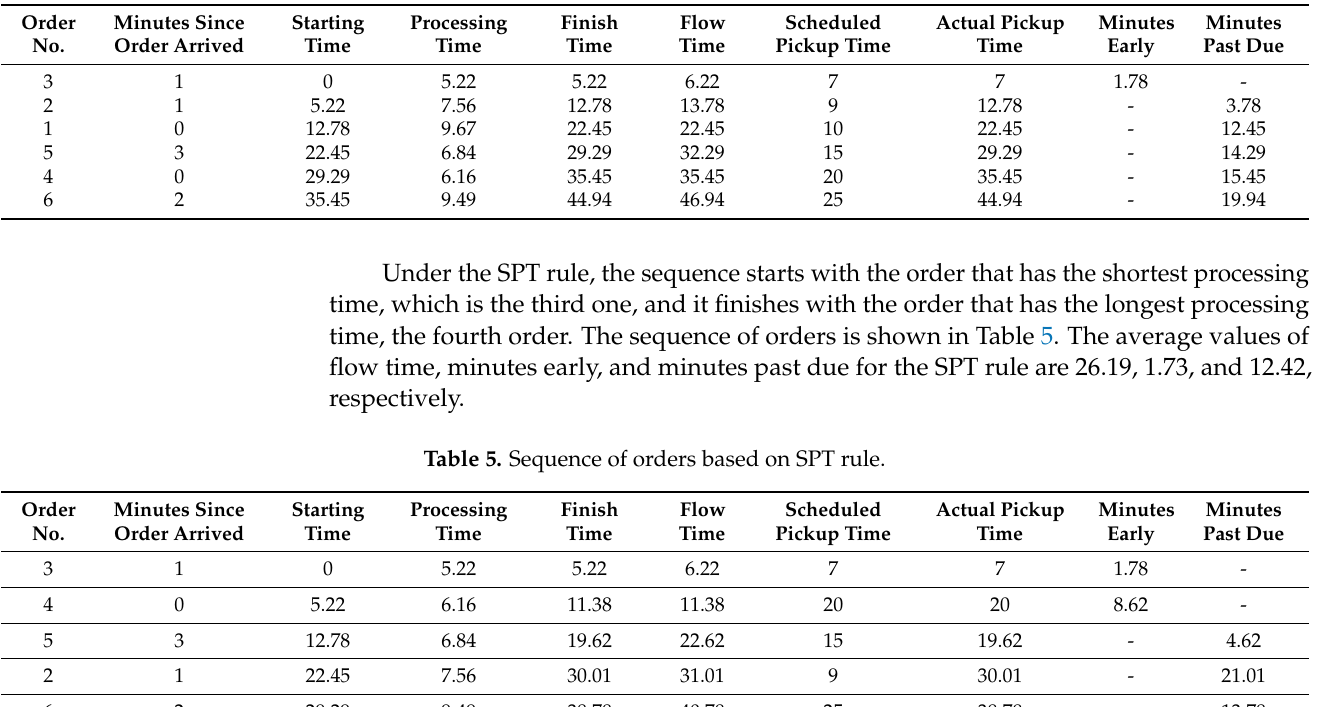
Table 4. Sequence of orders based on EDD rule.